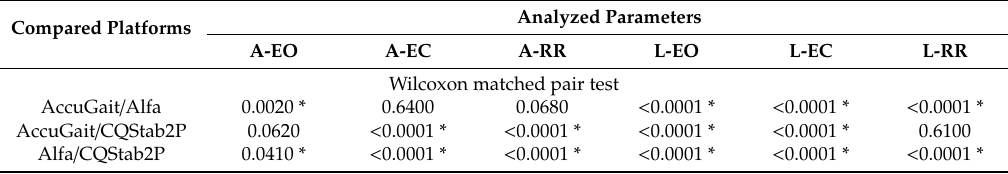
Table4. ResultsoftheWilcoxonmatchedpairtestfortheanalyzedplatformsforallanalyzedparameters. Compared